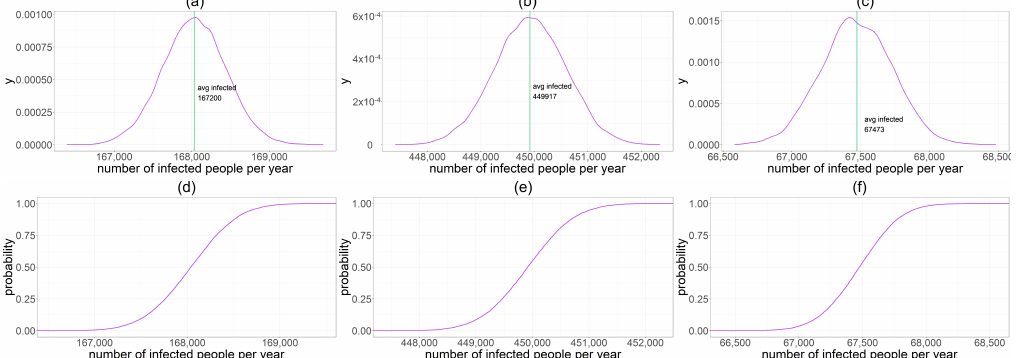
Figure 2. They are named from ( a – f ) from the top left corner to bottom right. ( a ) Density distribution of new HEV infected individuals per year X PL . The green line indicates the mean value N PL ( b ) Density distribution of new HEV infected individuals per year X PNL . The green line indicates the mean value N PNL . ( c ) Density distribution of new HEV infected individuals per year X SH . The green inf line indicates the mean value N SH . ( d ) Cumulative distribution of X PL . ( e ) Cumulative distribution inf of X PNL . ( f ) Cumulative distribution of X SH